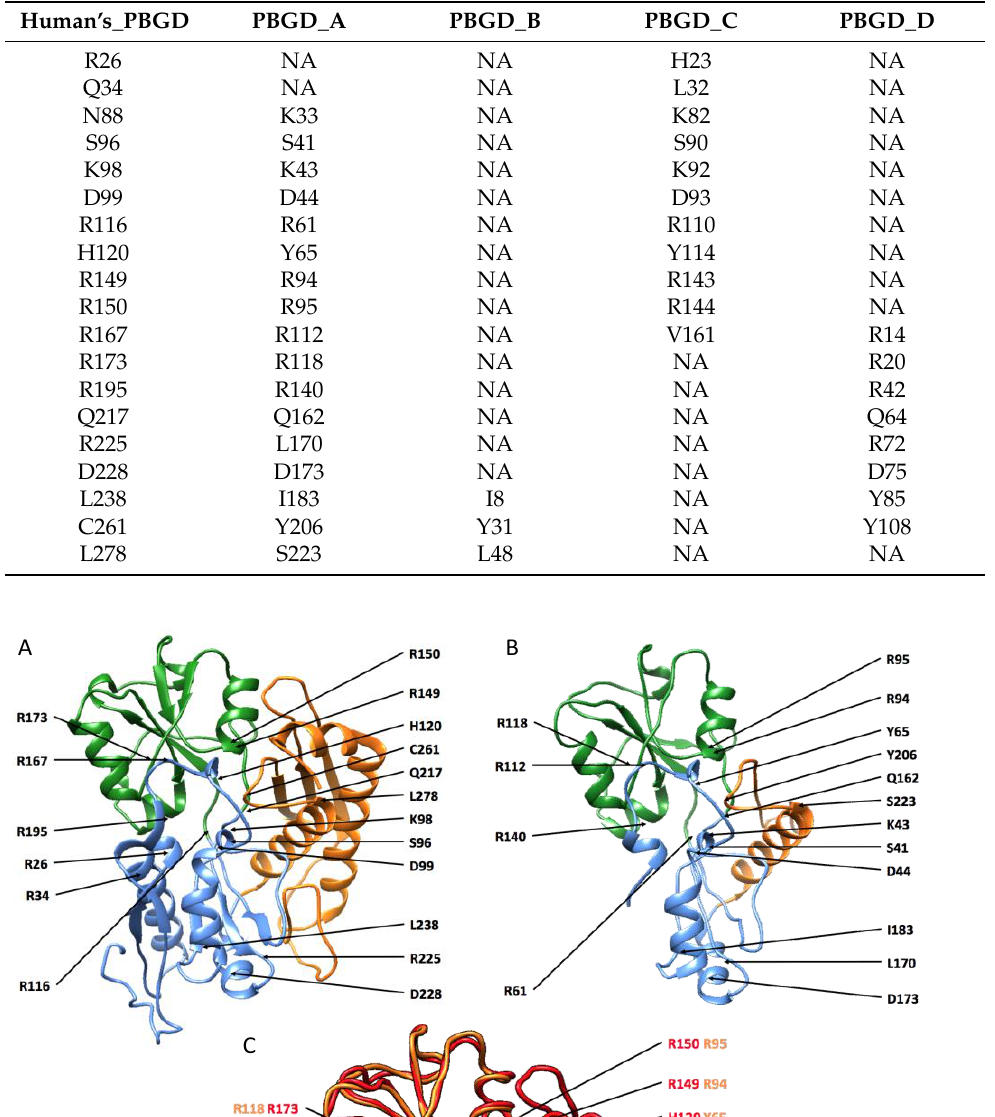
Table 1. Conservation of key residues between P. margaritifera PBGDs and human PBGD. Amino acid numbering is based on the alignment given in Figure 5.